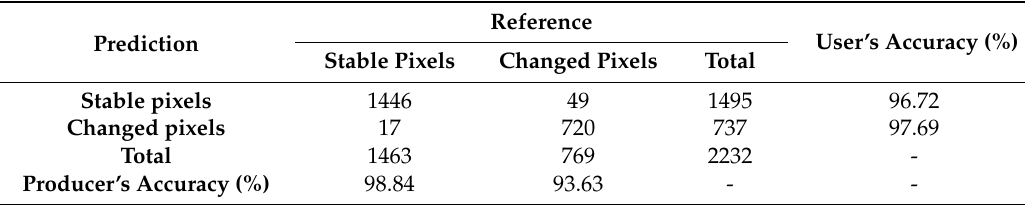
Table 4. Change detection assessment of the RF-TF algorithm.